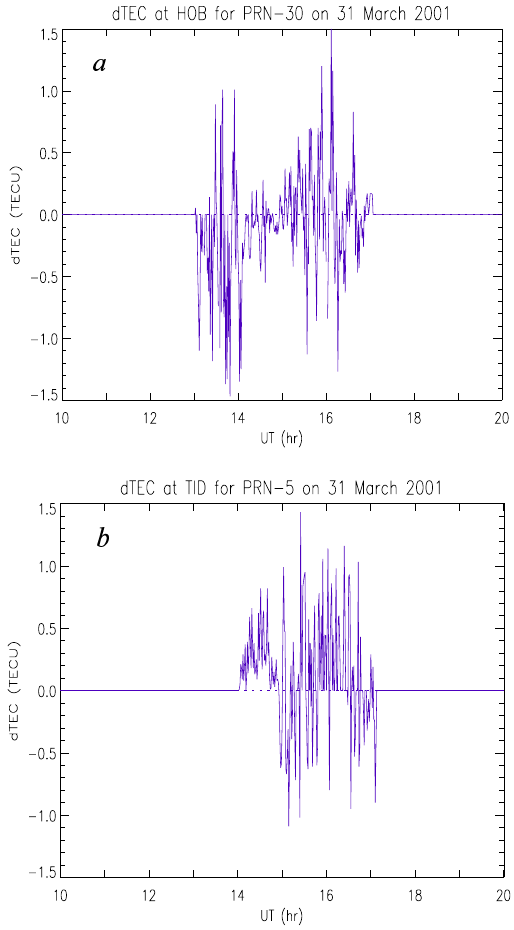
Fig. 7. The rate of change of TEC (dTEC) during three severe storm periods, demonstrating that in both cases the TIDs were migrating towards north